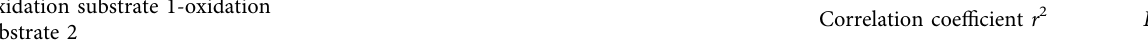
Table 2: Linear correlation coefcients between oxidation rates of two CYP substrates or between rates of two conjugation substrates and their respective P values in liver samples of male LDLr − / − ApoB 100/100 mice fed with the chow or Western diet. Te rates of CYP oxidation, glucuronidation, sulfonation, or COMTwith the indicated substrates were determined as described in Materials and Methods. Correlations were calculated from the data in Figures 2 and 3.